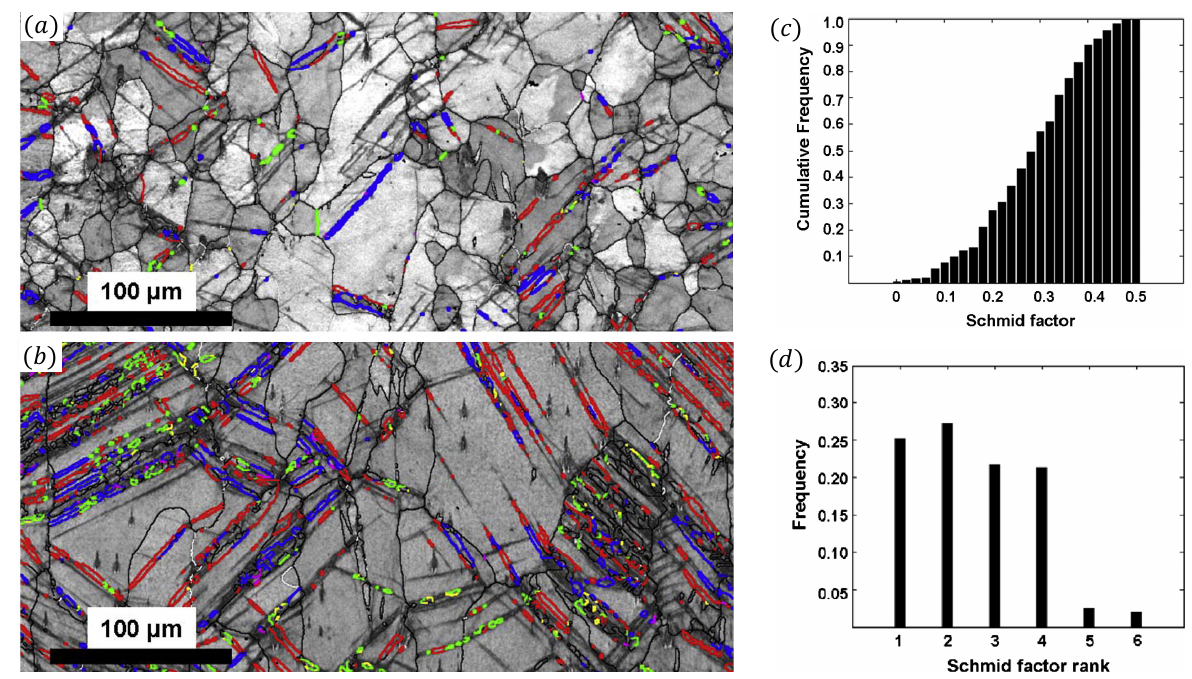
Figure 19. EBSD maps showing { 1011 } contraction twin boundaries in ( a ) AM30 and ( b ) AZ31 specimen at a tensile strain of 0.15. ( c ) The cumulative frequency of the Schmid factors associated with the primary twins and ( d ) frequencies of occurrence of primary twins displayed in terms of their Schmid factor rand (‘1’ being the highest and ‘6’ being the lowest in particular grain), reproduced from [222], with permission from Elsevier